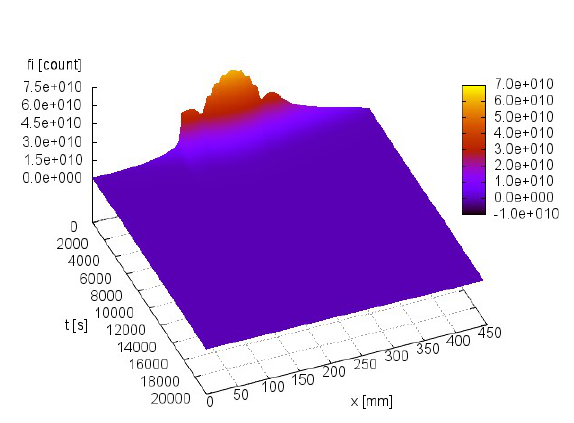
Figure 3. Neutron flux distribution for energy group 0 . 0253 eV in Case 1 (the neutron flux decreases with time evolution due to deep subcritical state).